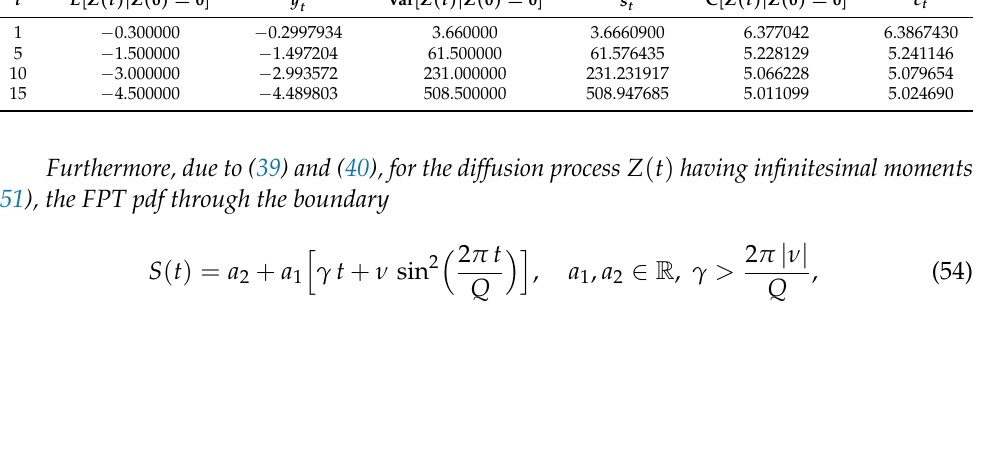
, s 2 and c t , obtained by t t